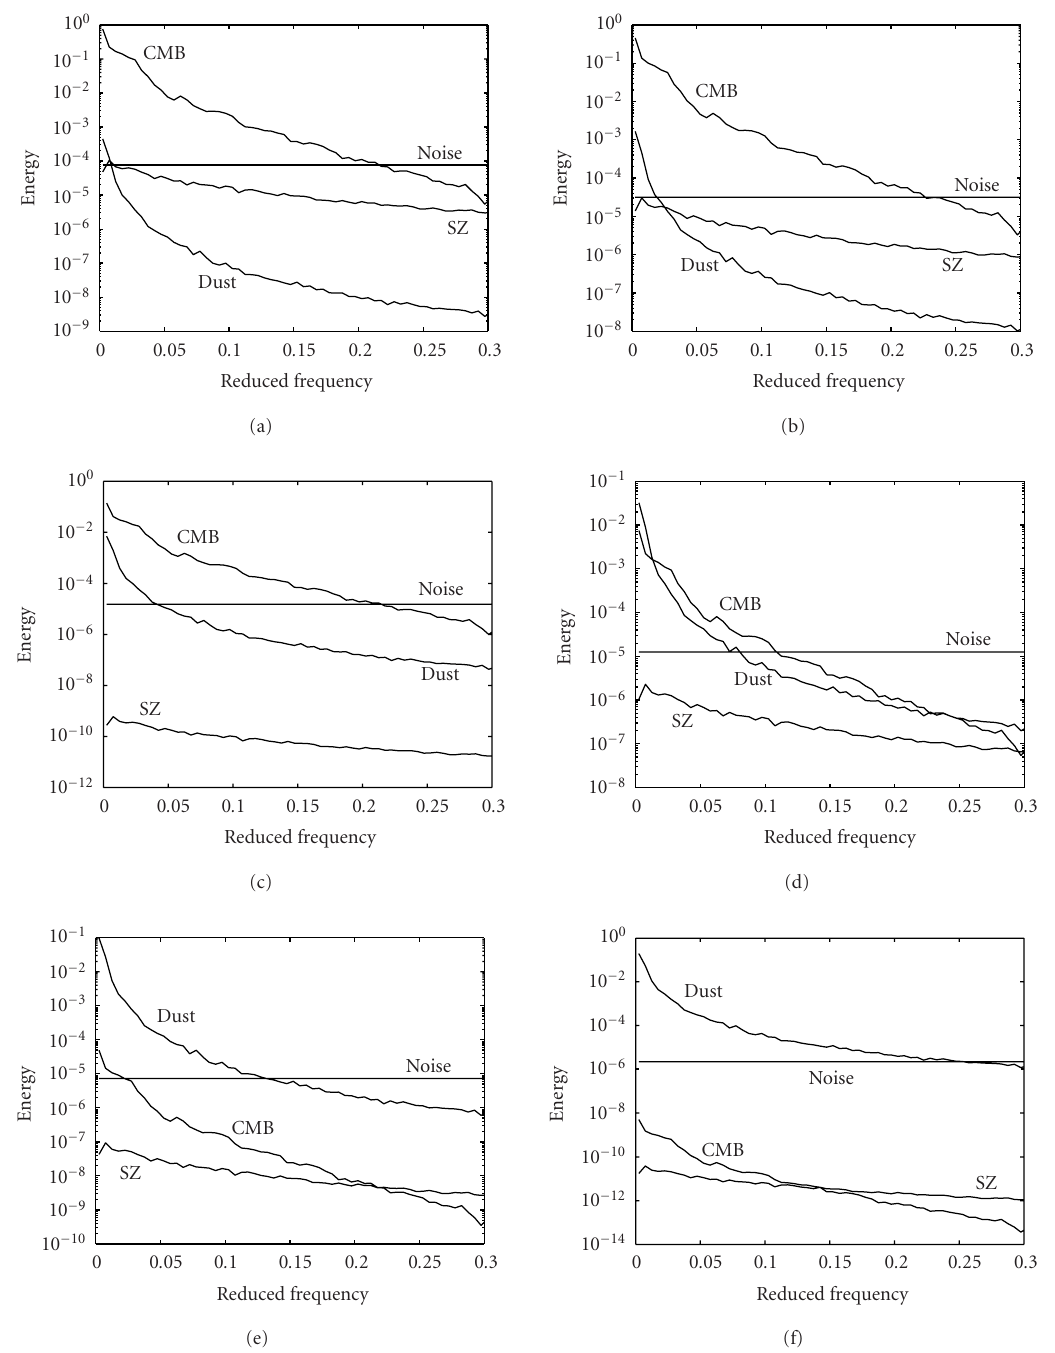
Figure 4: Energy contributed by each source and noise in each bolometer as a function of frequency, for the nominal noise variance on the Planck HFI channels: (a) 100GHz, (b) 143GHz, (c) 217 GHz, (d) 353 GHz, (e) 545 GHz, and (f) 857GHz. Note how SZ is expected to be always below nominal noise, that CMB and dust strongly dominate in di ff erent channels, and that CMB and dust spectra, without being proportional, display the same general behavior dominated by low